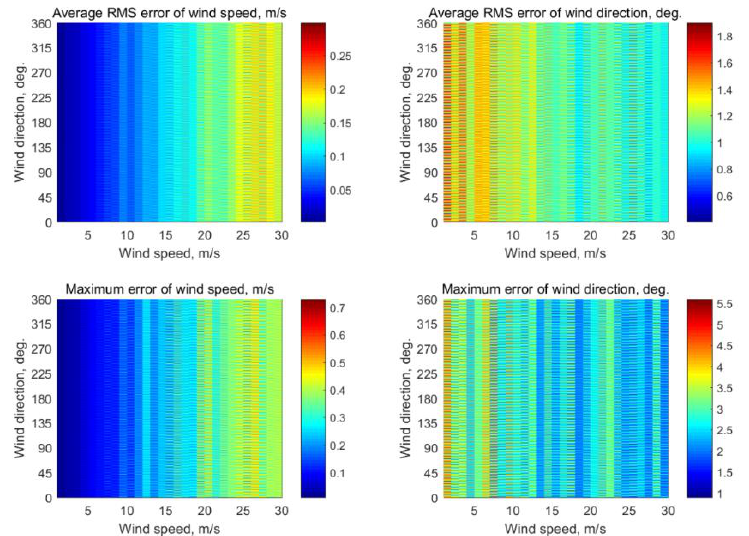
Figure A8. Simulation results of the use of two incidence angles of 30° and 35° for wind retrieval.